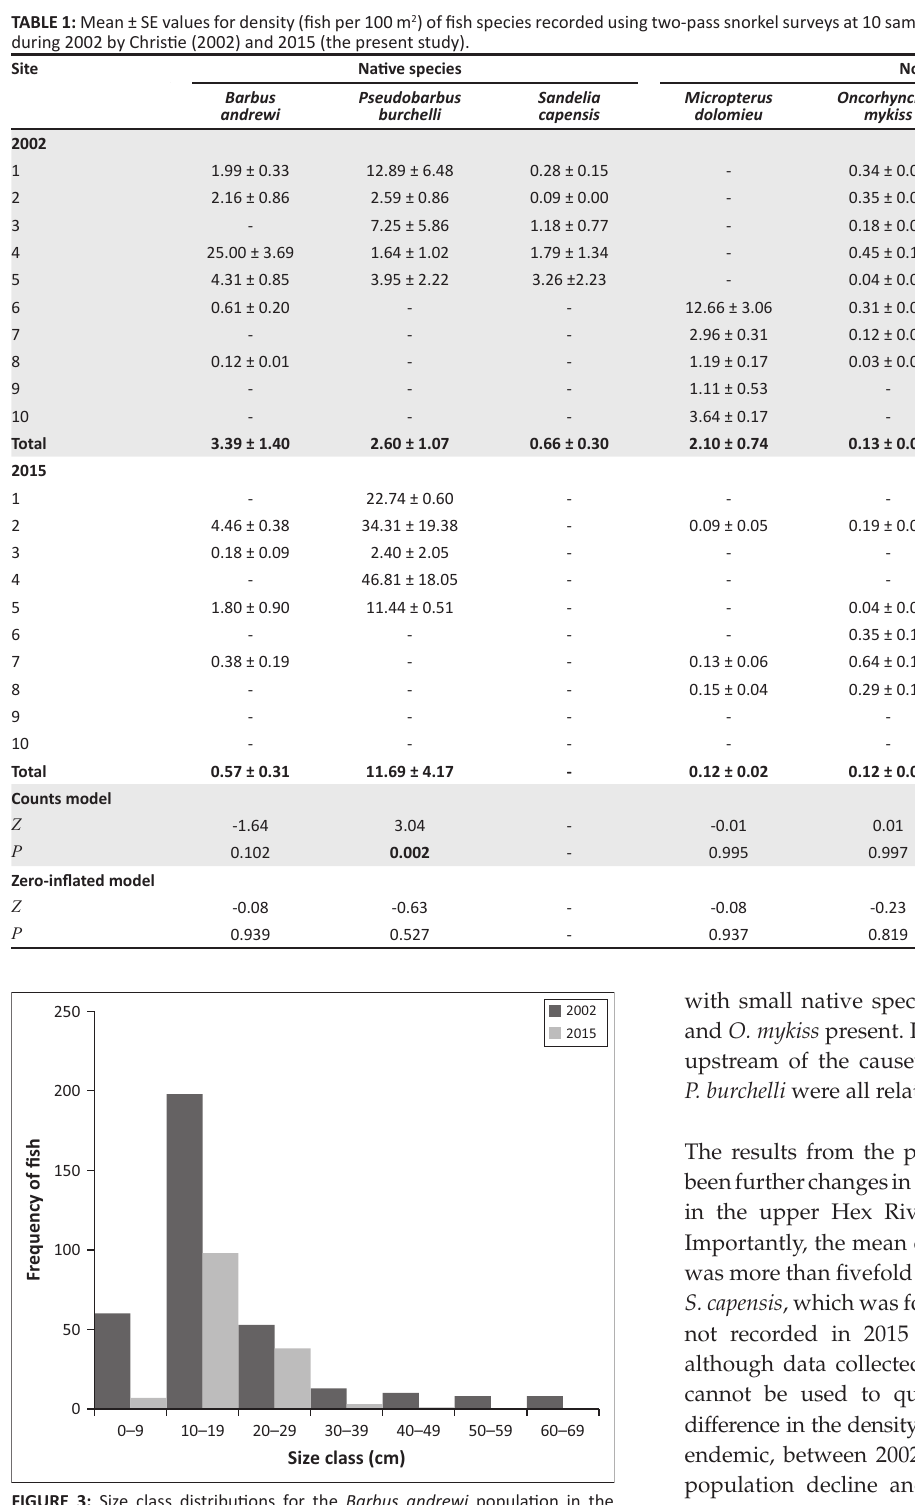
FIGURE 3: Size class distributions for the Barbus andrewi population in the upper Hex River in 2002 (Christie 2002; dark bars) and 2015 (light